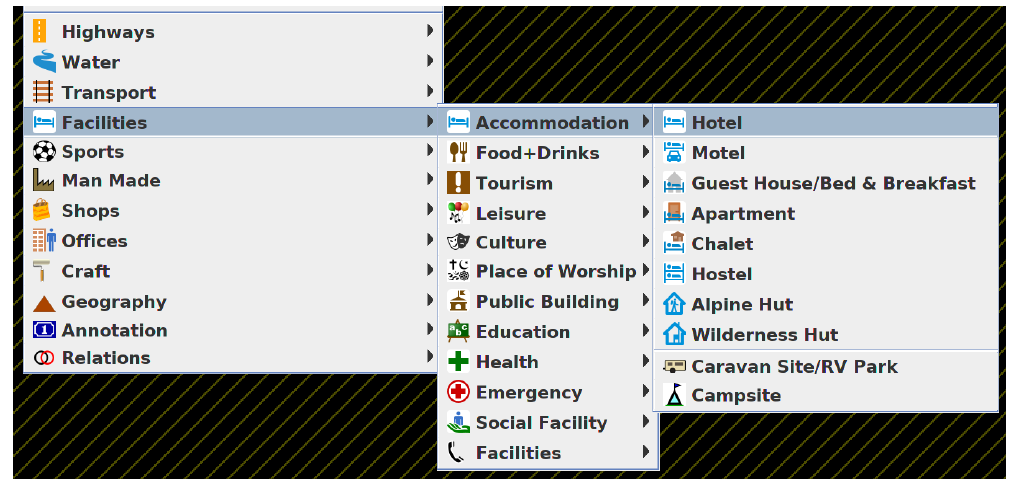
Figure 3. An example of the default JOSM preset with different category levels.